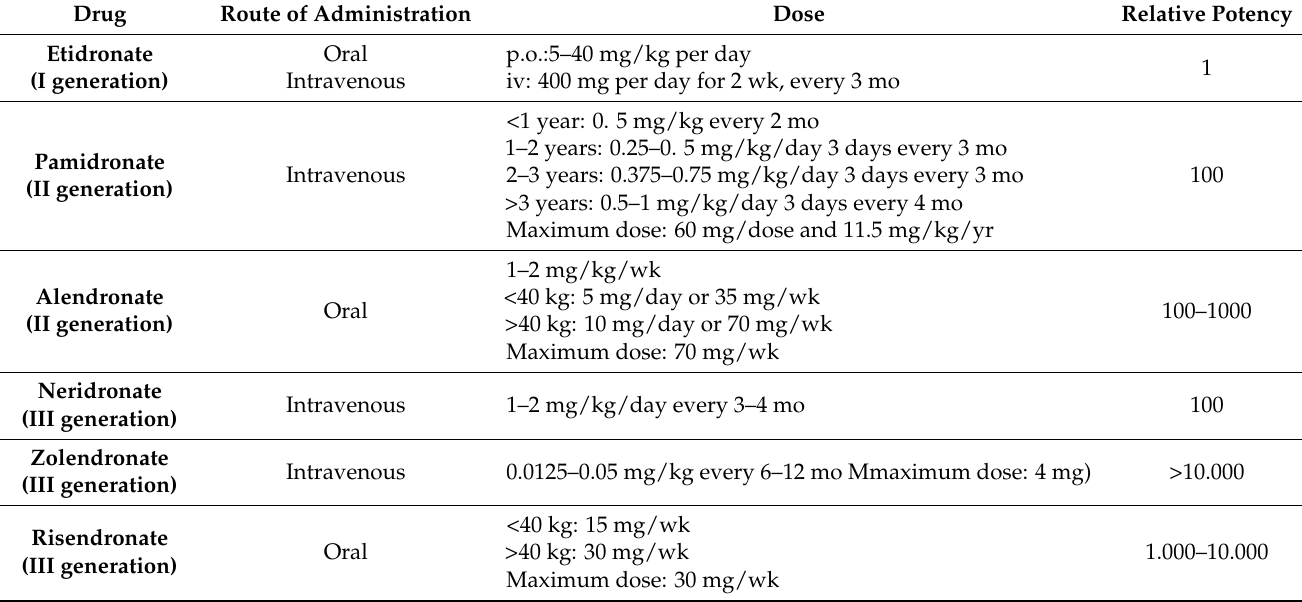
Table 2. Main bisphosphonates used in the paediatric